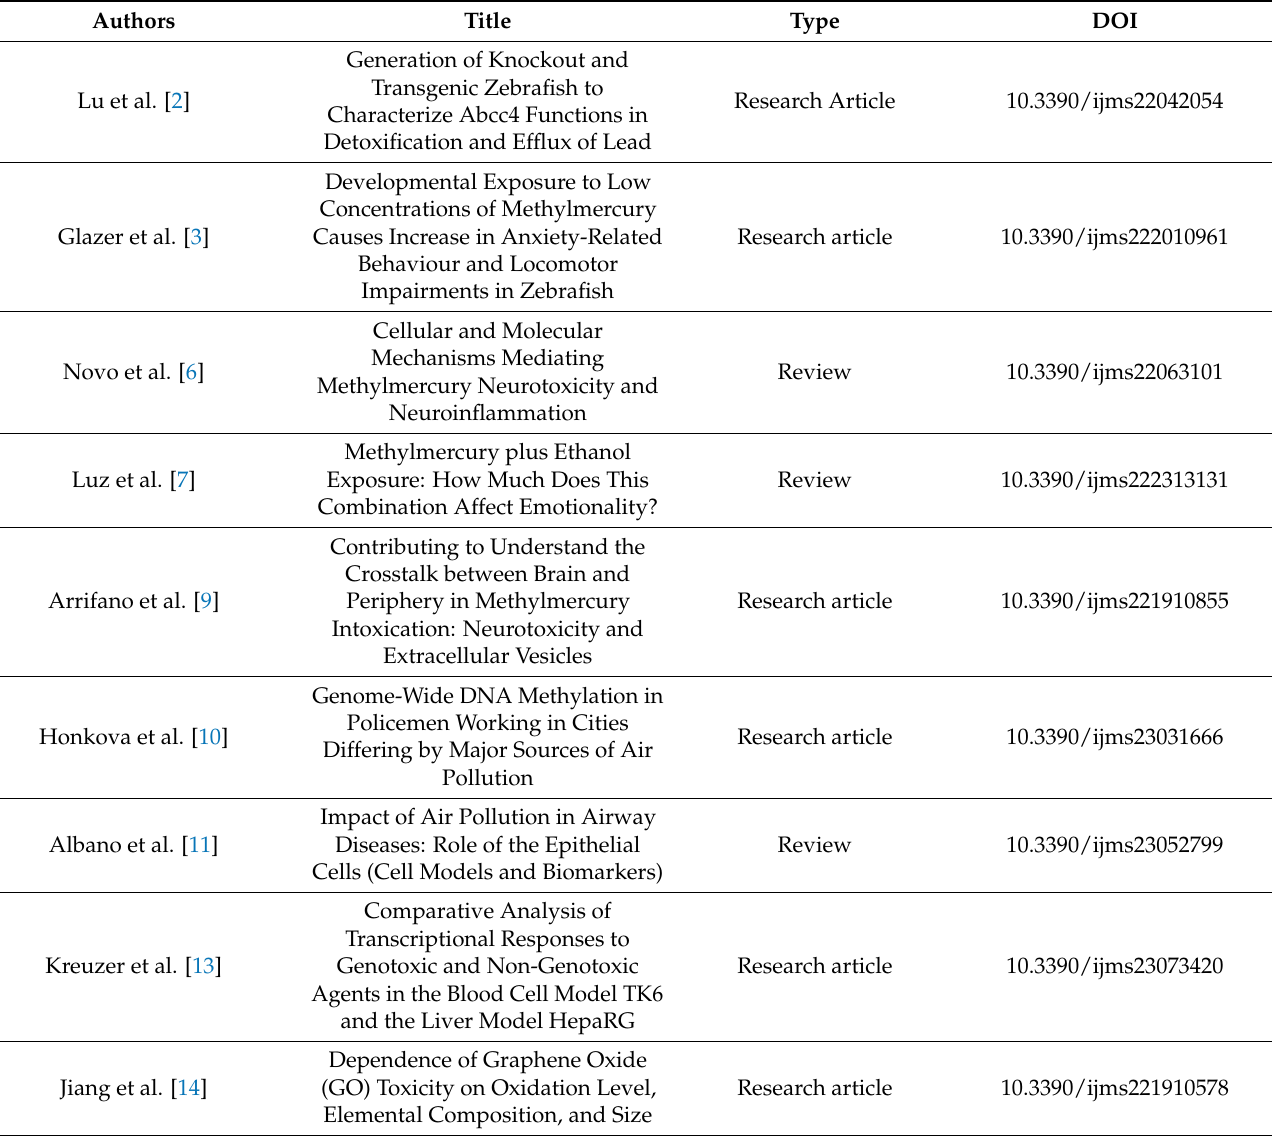
Table 1. Summary of the nine articles included in the Special Issue “Toxicogenomics and Molecular Markers in Pollution” of the International Journal of Molecular Sciences